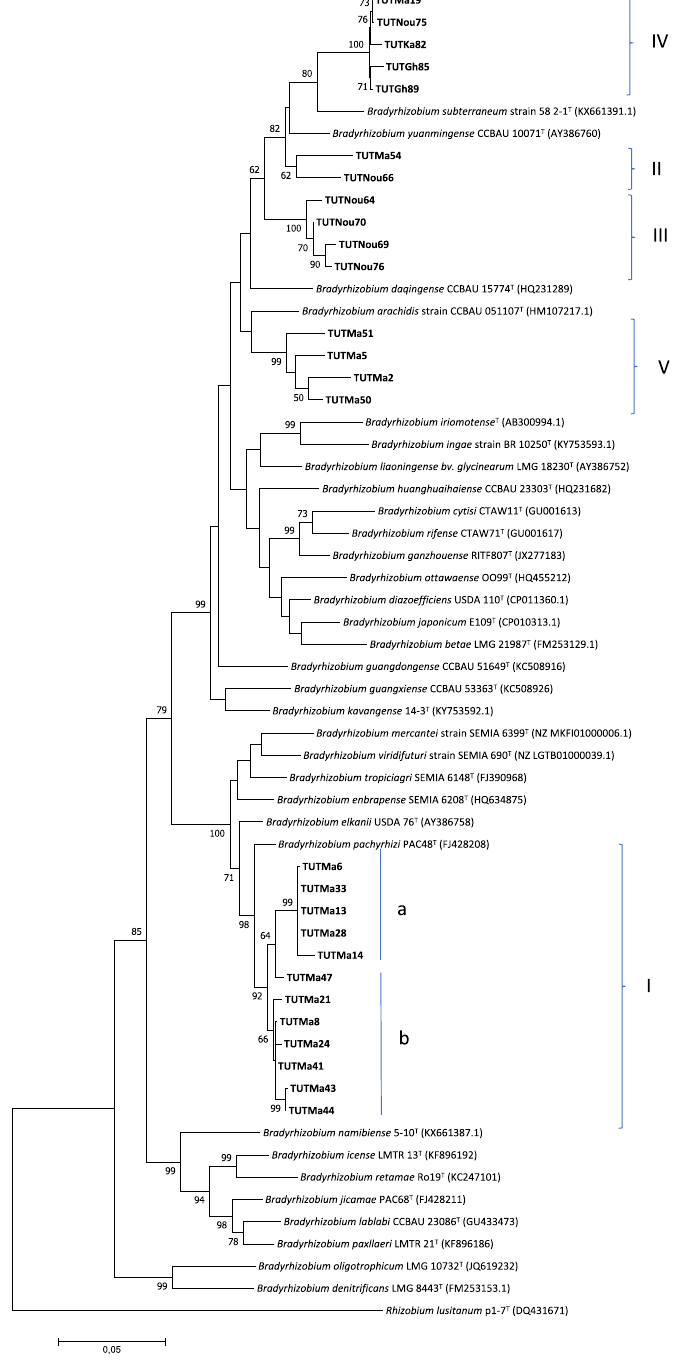
Figure 4. Phylogenetic tree based on atp D- gln II -gyr B -rec A genes sequences generated by Maximum likelihood method. Bootstrap values (1000 replicates) are indicated above the branches which shows the percentage of trees in which the associated taxa clustered together. The number of nucleotide substitution is indicated by scale bar. All missing and gap nucleotide sequences were eliminated during phylogenetic tree construction. Evolutionary analyses were conducted in